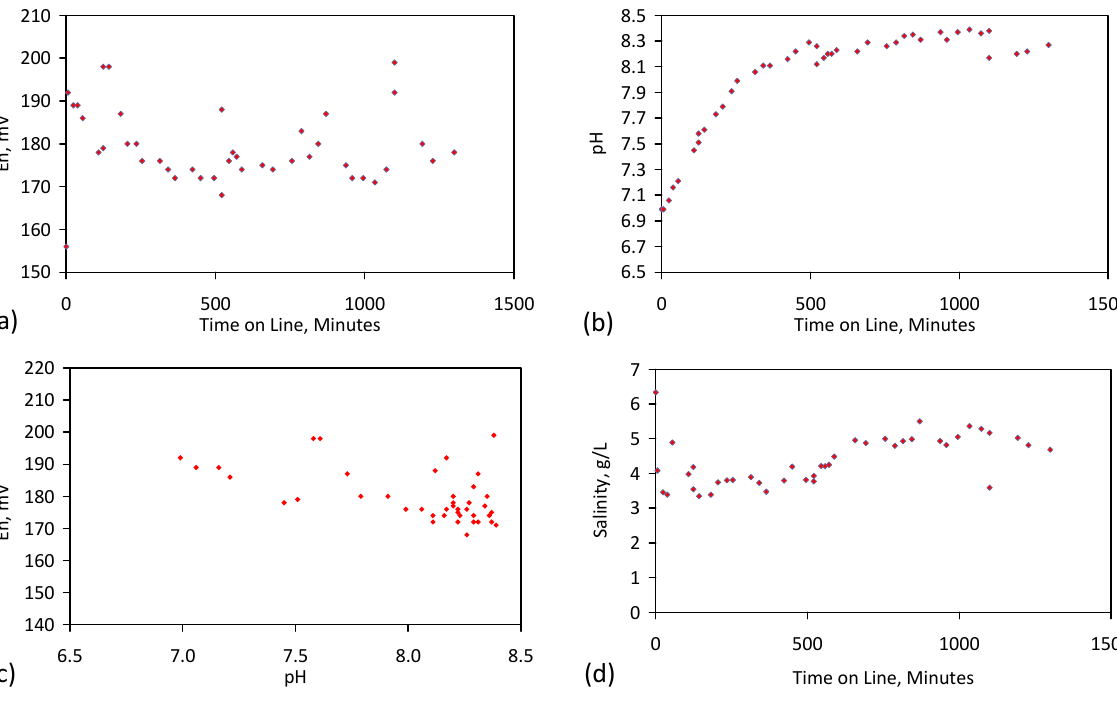
Figure C22. ZVM TPA example Trial E146. 2nd Reuse; Operating Temperature: 15–22 °C; Oxidising Environment: Water volume in the reactor = 0.24 m 3 ; ZVM TPA from Trial E145 in a cartridge = 0.4 kg; Air flow = 120 L·h − 1 . ( a ) Eh vs. time; ( b ) pH vs. time; ( c ) pH vs. Eh; ( d ) Salinity vs. time; ( e ) Salinity calculated from normalised data vs. salinity calculated from raw data; ( f ) EC vs. time.